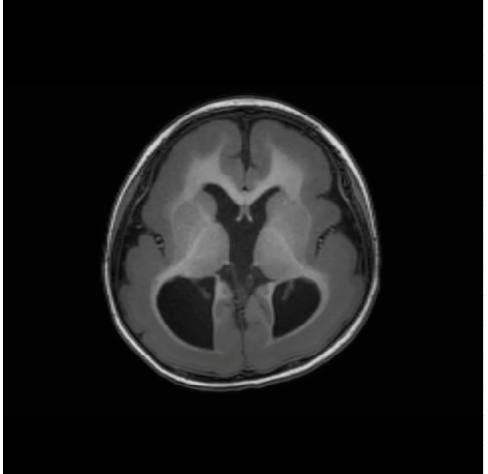
Figure 1. Brain magnetic resonance image (MRI) showing lissencephaly.